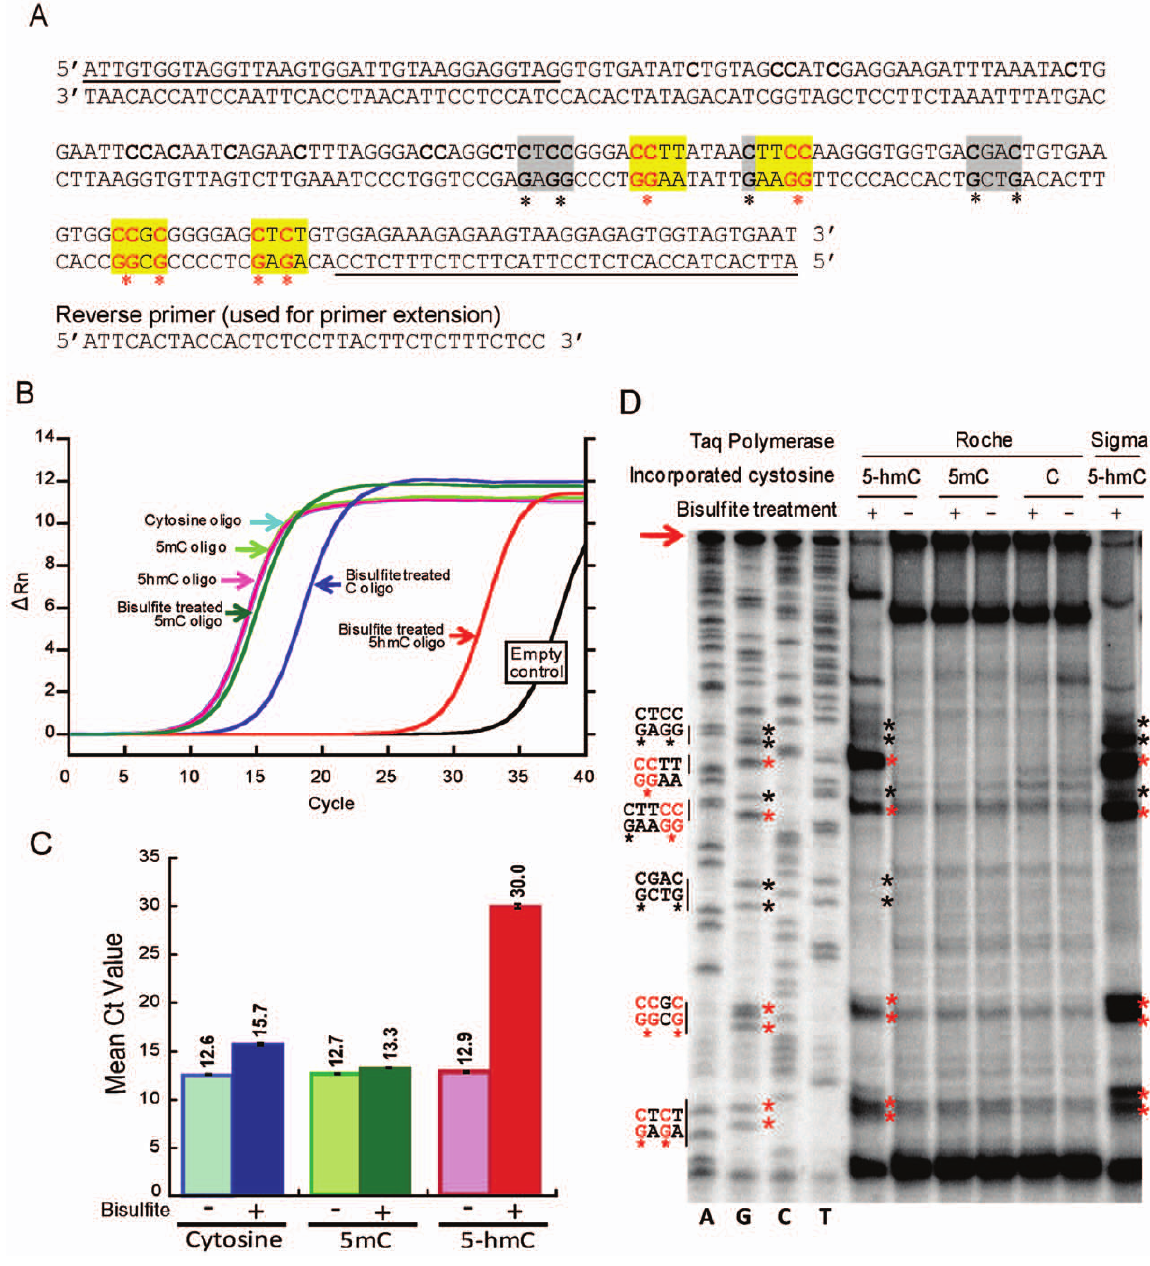
Figure 2. The bisulfite adduct of 5-hmC hinders PCR amplification. (A) Sequence of oligonucleotide containing multiple cytosines (used in Figures 2B-D ). The yellow highlighted sequences and the red asterisks indicate the sequences and cytosine (putative CMS) residues at which DNA polymerases tended to stall when bisulfite-treated 5-hmC-containing DNA was used as template, whereas the grey highlighted sequences and black asterisks indicate the sequences and cytosine (putative CMS) residues that cause weak or no stalling by the DNA polymerases